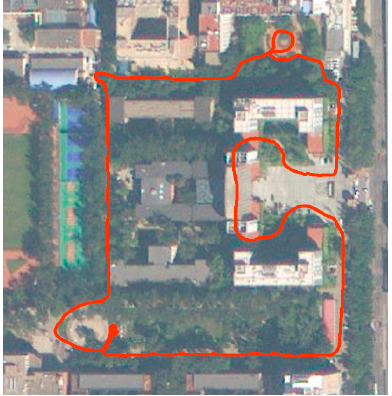
Figure 9. The Google map and the trajectory of campus experimental data.